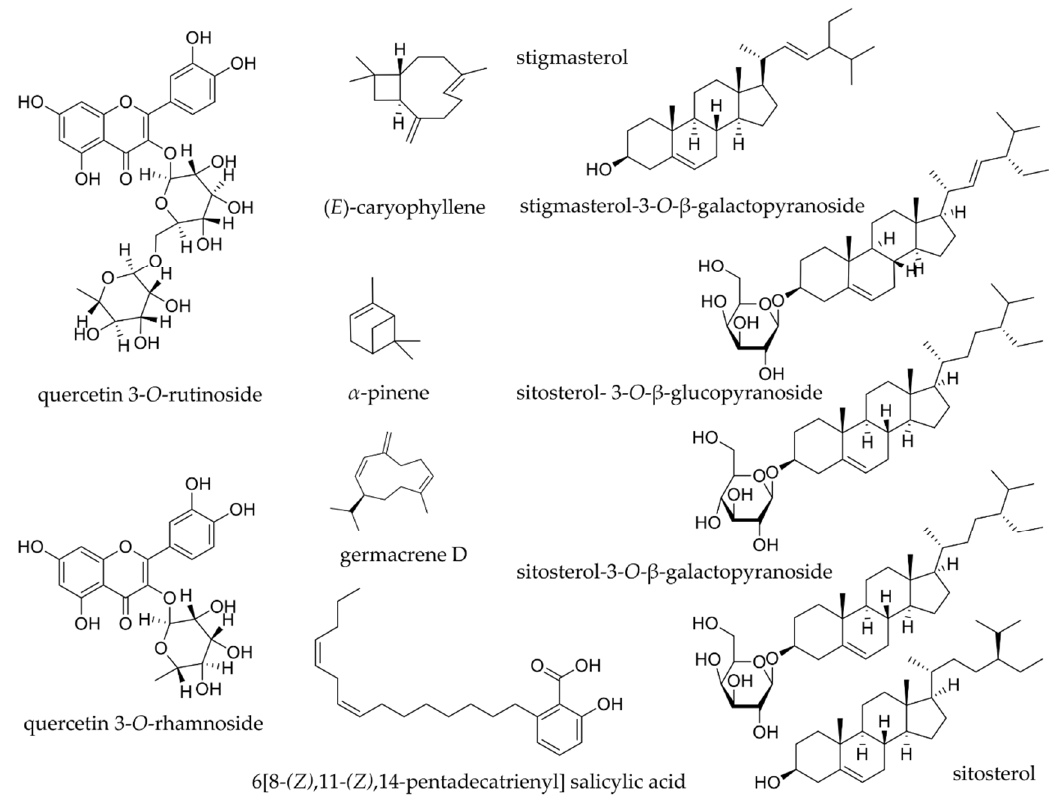
Figure 2. Chemical structures of Anacardium compounds with biological activities.